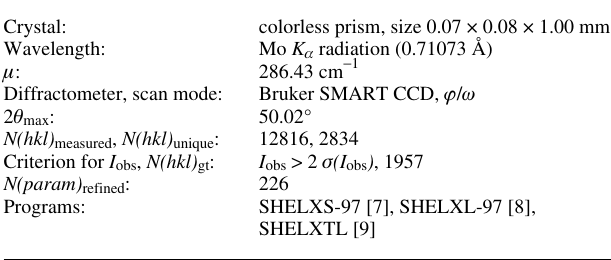
Table 1. Data collection and handling.